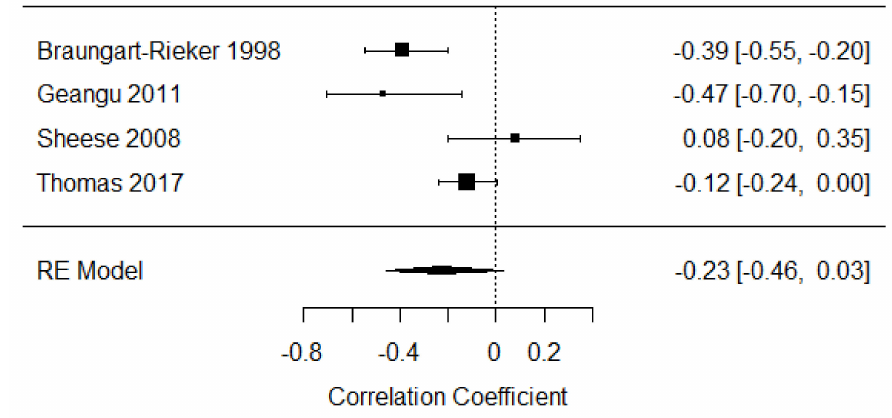
Figure 9. Forest plot of year 1 self-soothing strategies. Note: RE = Random-Effects Model. Second Year of Life